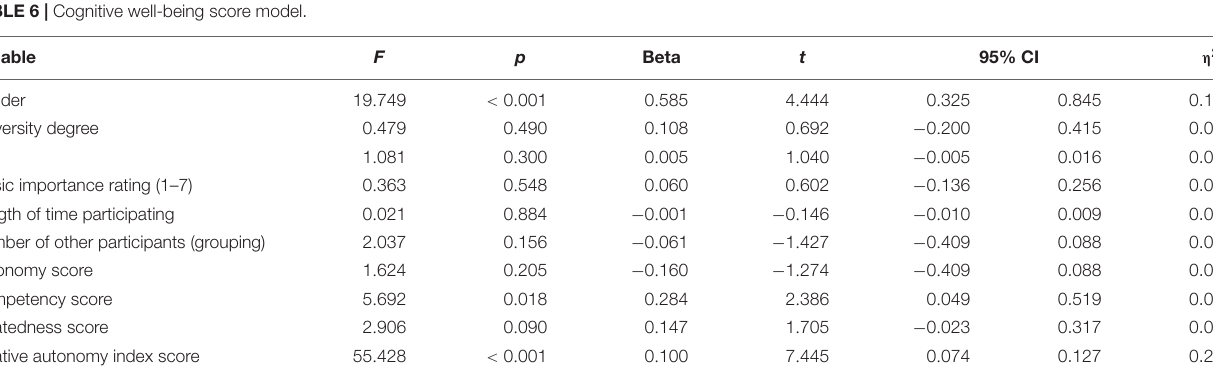
TABLE 6 | Cognitive well-being score